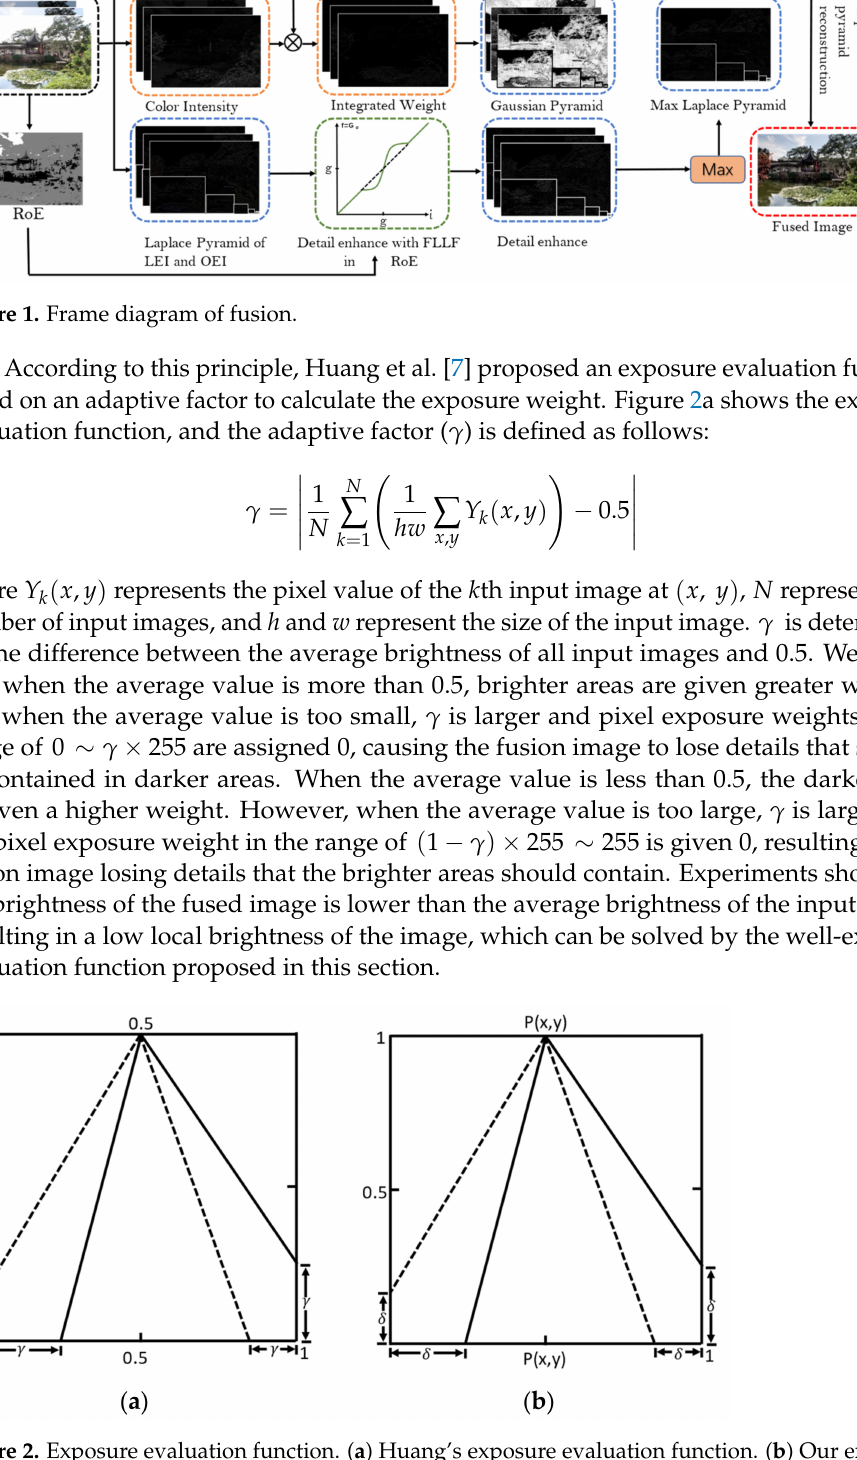
Figure 2. Exposure evaluation function. ( a ) Huang’s exposure evaluation function. ( b ) Our exposure evaluation